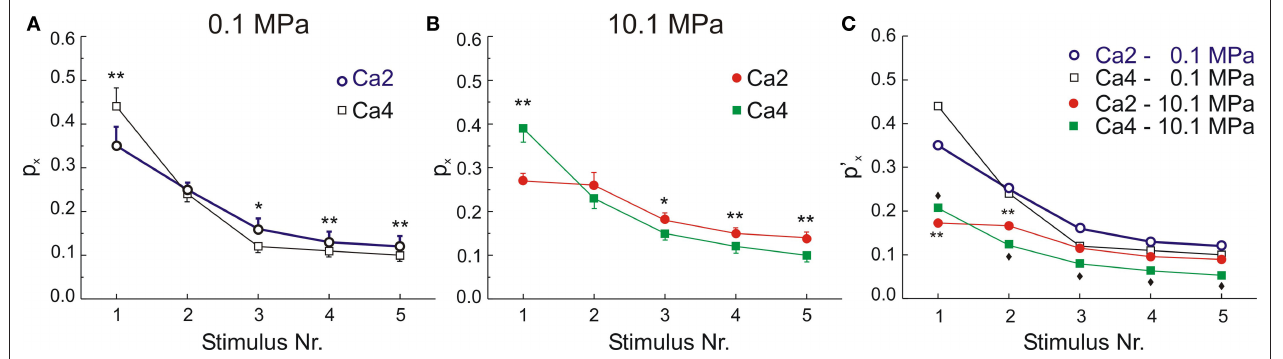
Figure 6 | effects of [Ca 2 + ] on dynamics of MPP synaptic variables during o 50 Hz stimulation at two different pressures. (A) High [Ca 2 + ] significantly o increases P , but it significantly reduces the P with respect to their respective 1 3-5 controls. (B) At 10.1 MPa high [Ca 2 + ] also increases P at expenses of P o 1 2–5 denoting reduction of E . Graphs display means ± SE, n = 6 for each T condition * p < 0.05 and ** p < 0.01 (paired t -test). (C) Differential effects of